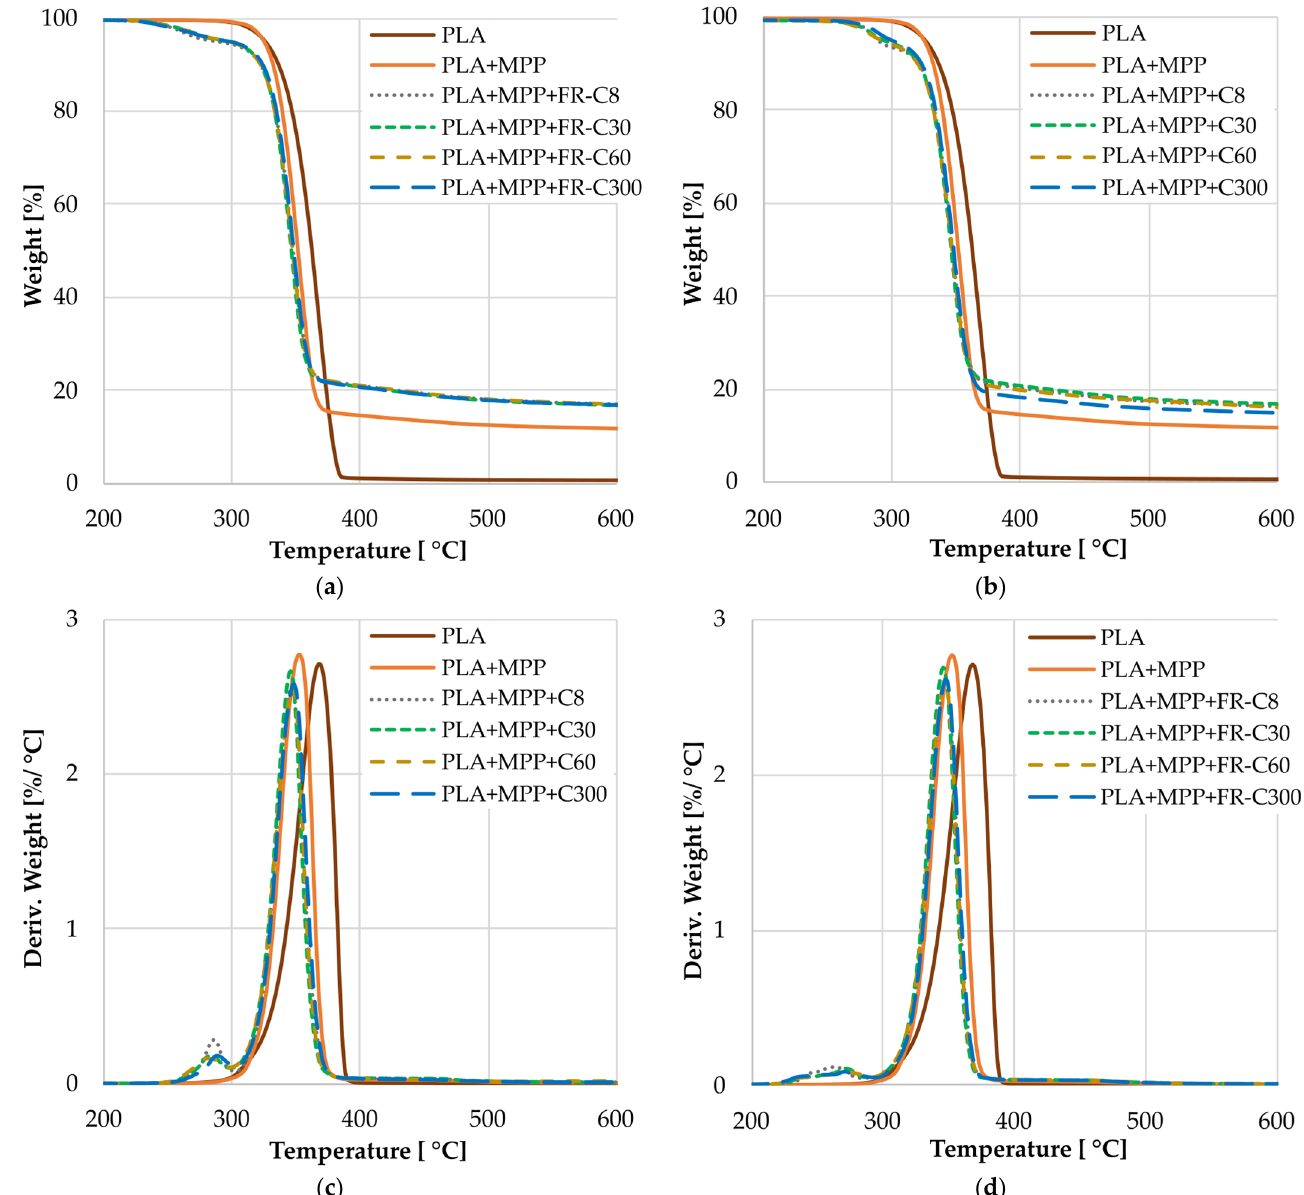
Figure 5. TGA curves of the composites with ( a ) untreated cellulose additives and ( b ) FR-treated cellulose additives; and the DTG curves of the ( c ) untreated cellulose additives and ( d ) FR-treated cellulose additives.